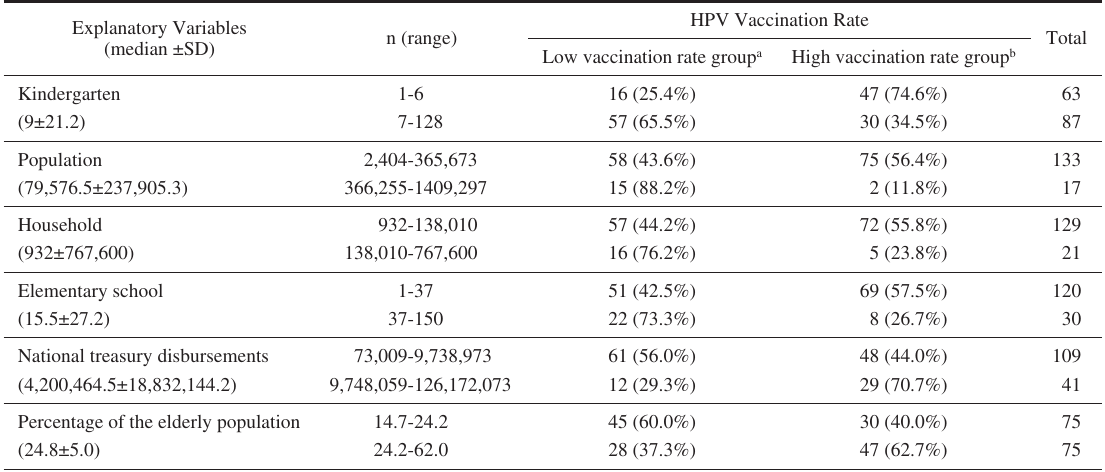
T a ble 3 Cross table of u ni v ariate anal y sis of H PV v accination rate for characteristics of local g o v